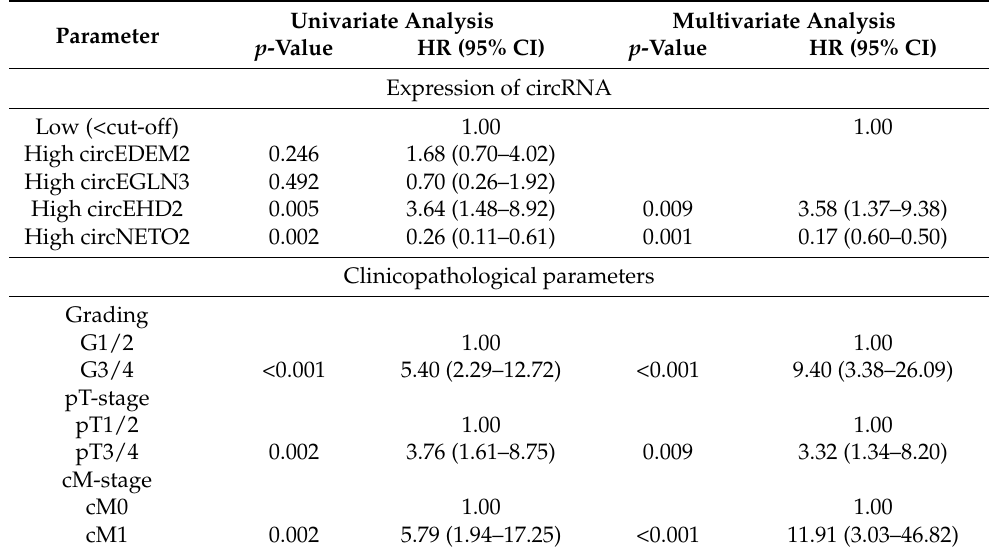
Figure 3. Kaplan–Meier estimates demonstrate that circRNA expression of circEHD2 and circNETO2 is associated with clear cell renal cell carcinoma patients’ survival following nephrectomy. Table 2. Uni- and multivariate Cox regression analysis for progression-free survival.